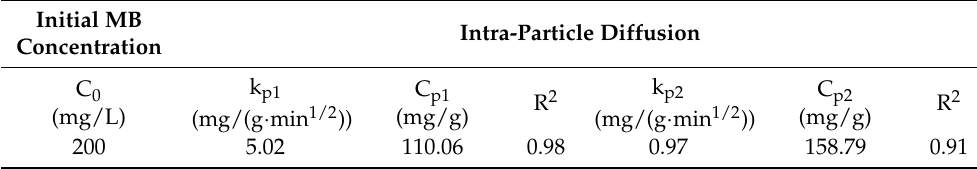
Table 4. Calculated kinetic constants of the IPD model in the MB adsorption process. Initial